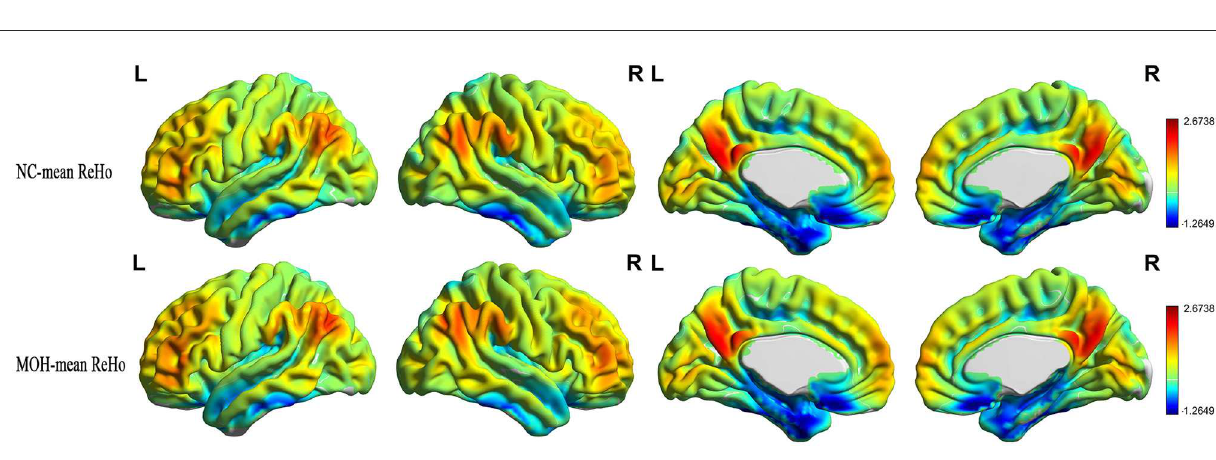
FIGURE3 Mean ReHo maps for the NC and MOH groups, showing no obvious difference in distribution over the entire gray matter level.